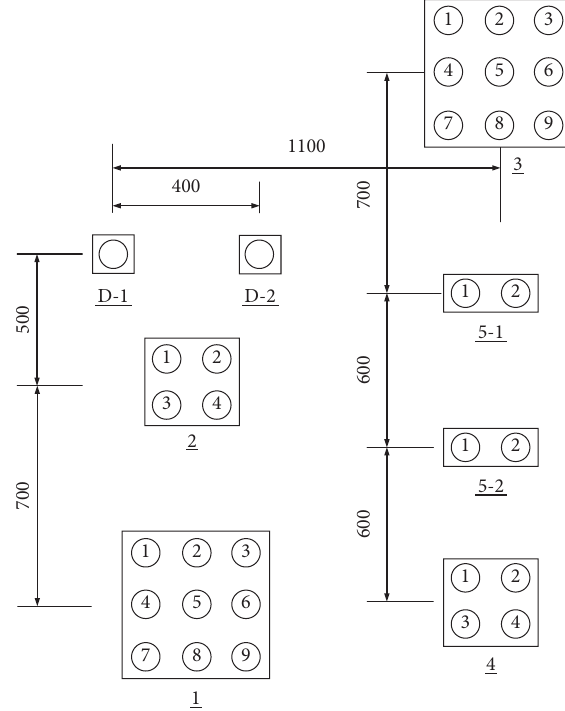
Figure 8: Layout plan of test piles and group piles.